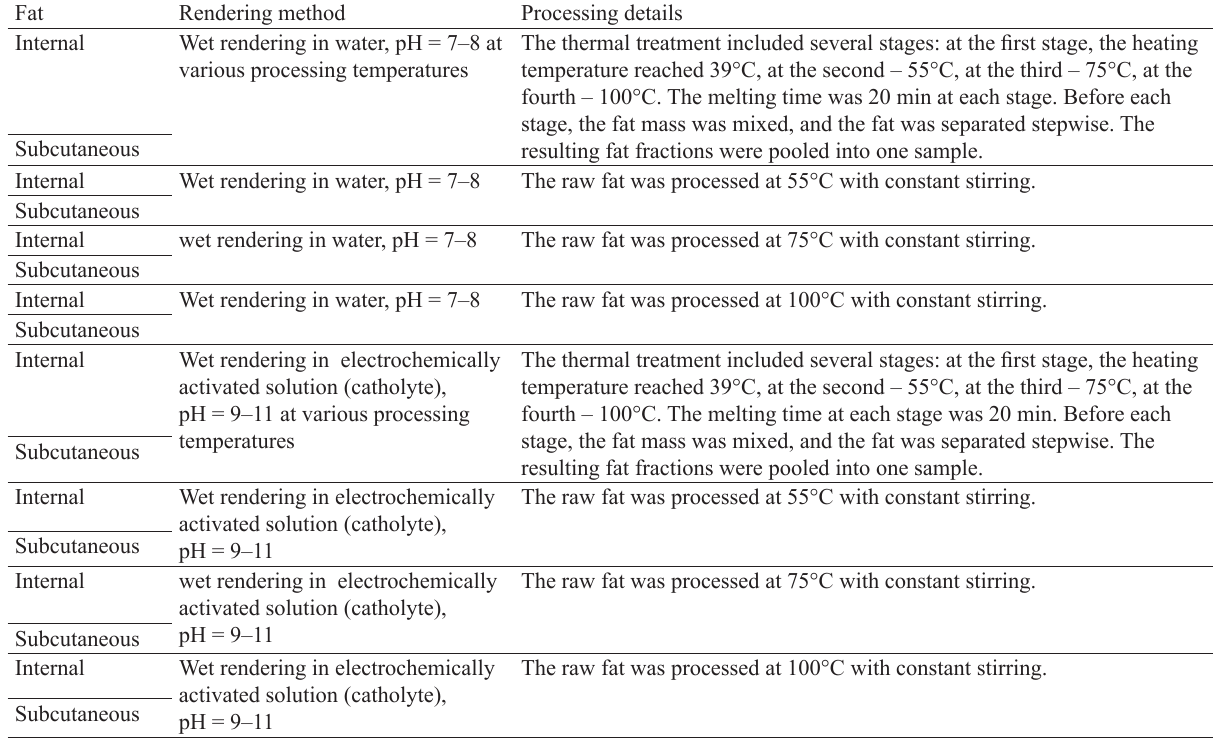
Table 2 Methods and modes of ostrich fat rendering Fat Rendering method Processing